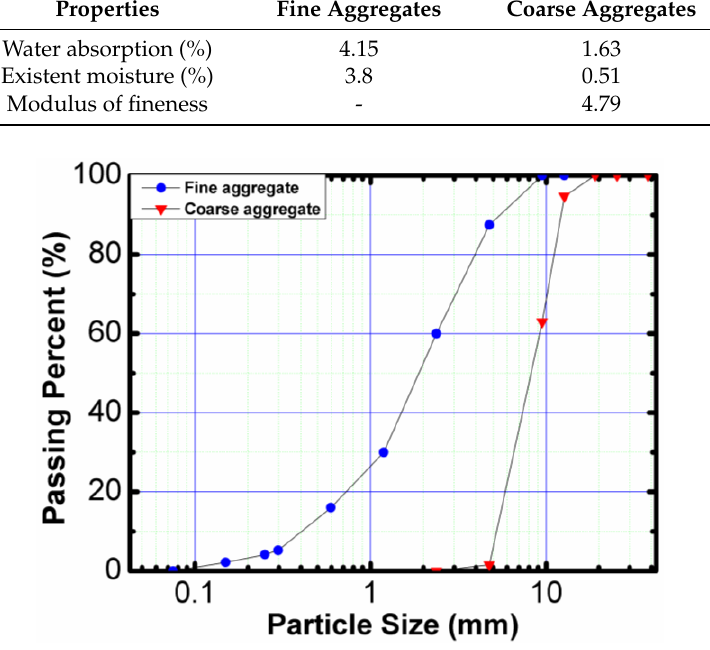
Figure 2. Particle size distribution of fine and coarse aggregates.